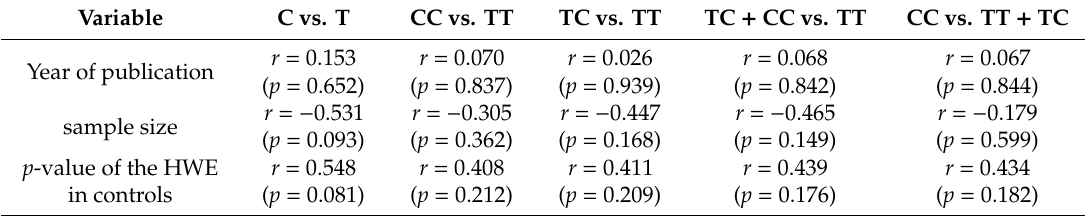
Table 4. Meta-regression analyses on year, sample size, and p -value of the HWE in controls for finding a potential source of heterogeneity between rs13041247 polymorphism and susceptibility to non-syndromic cleft lip /